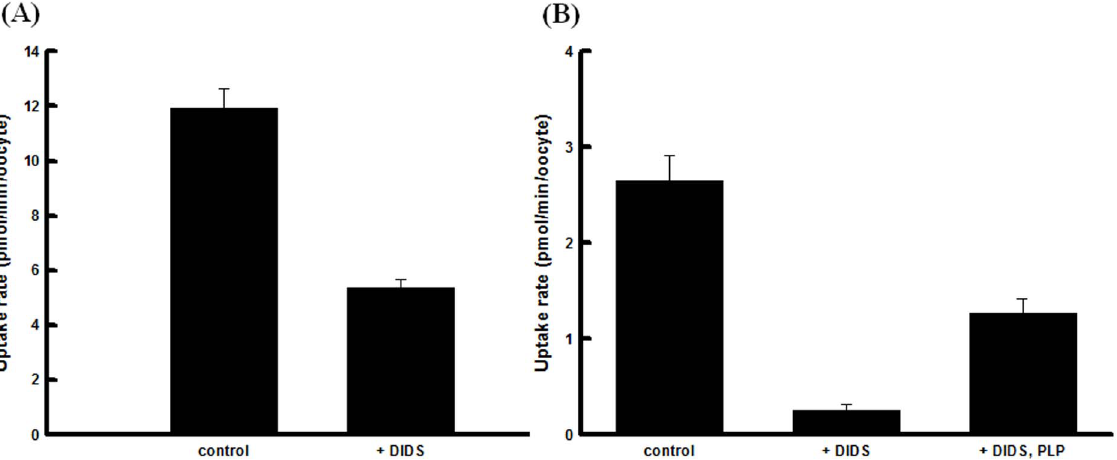
Figure 4. Effect of DIDS on transport activity via hMCT4. (A) Oocytes were incubated for 10 min at 25 u C with transport buffer of pH 5.5 containing 0.1 mM L-lactate in the absence or presence of 0.5 mM DIDS. Data are presented as means 6 S.E. of three independent experiments. The background uptake values of water-injected oocytes were subtracted. (B) Oocytes were preincubated at 25 u C for 10 min with/without 5 mM PLP (pH 7.5). L-lactate uptake after preincubation was measured. The oocytes were incubated for 10 min at 25 u C with transport buffer of pH 7.5 containing 0.1 mM L-lactate in the absence or presence of 0.5 mM DIDS. Data are presented as means 6 S.E. of three independent experiments. The background uptake values of water-injected oocytes were subtracted.